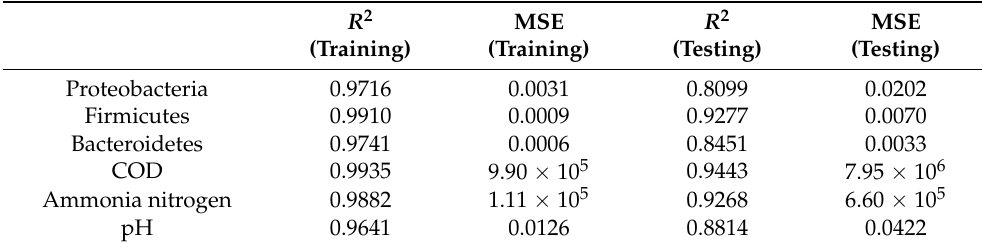
Table 8. Comparison of the RF prediction models based on